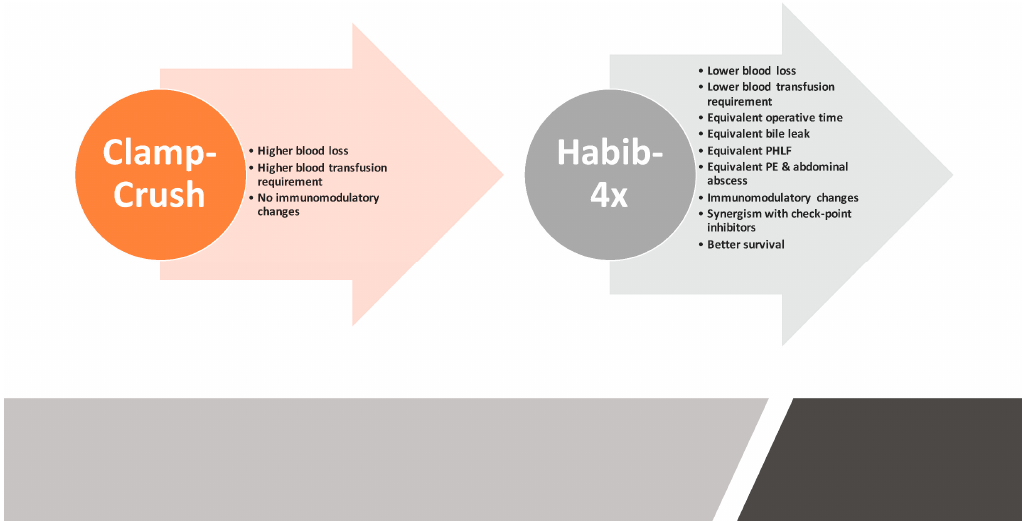
Figure 6. Comparative summary of the benefits of Habib™-4X based liver resection over the crush-camp technique. PHLF: Post hepatectomy liver failure; PE: Pleural effusion.